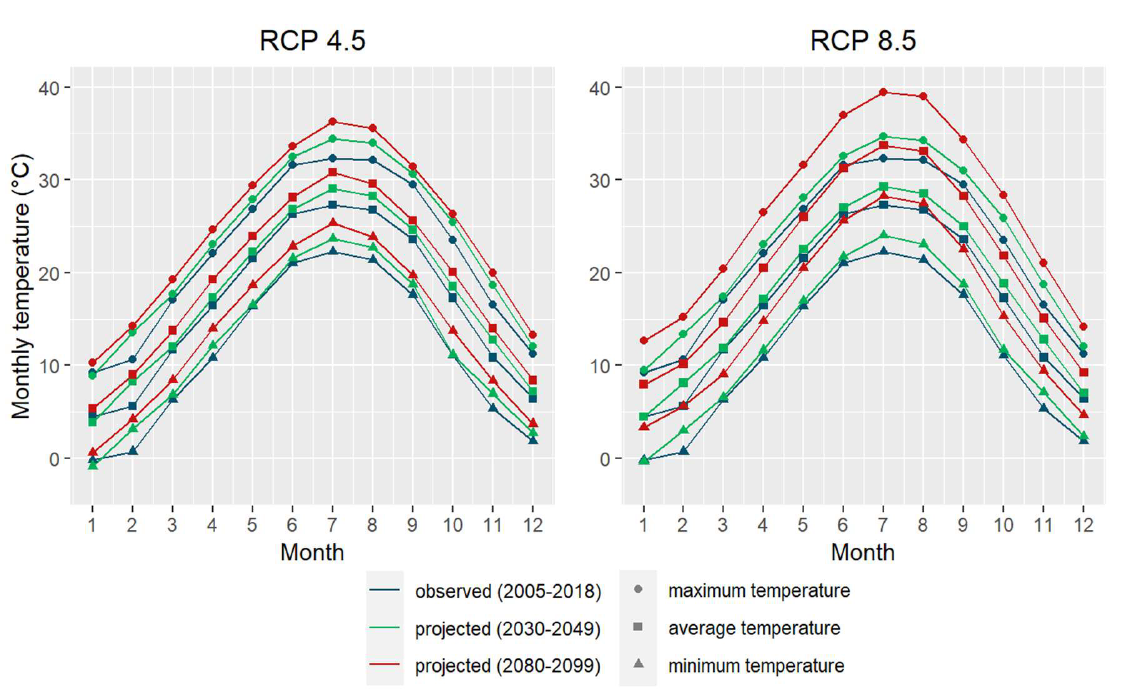
Figure 2. Monthly temperatures observed between 2005 and 2018 and projected for 2030–2049 and 2080–2099. The projected temperatures represent the averages of temperatures projected by 32 global climate models under Representative Concentration Pathways (RCPs) 4.5 (left) and 8.5 (right). The colors and symbols in the legend denotes the maximum (circle), average (square), and minimum (triangle) temperatures observed between 2005–2018 (blue) and projected for 2030–2049 (green) and 2080–2099 (red).